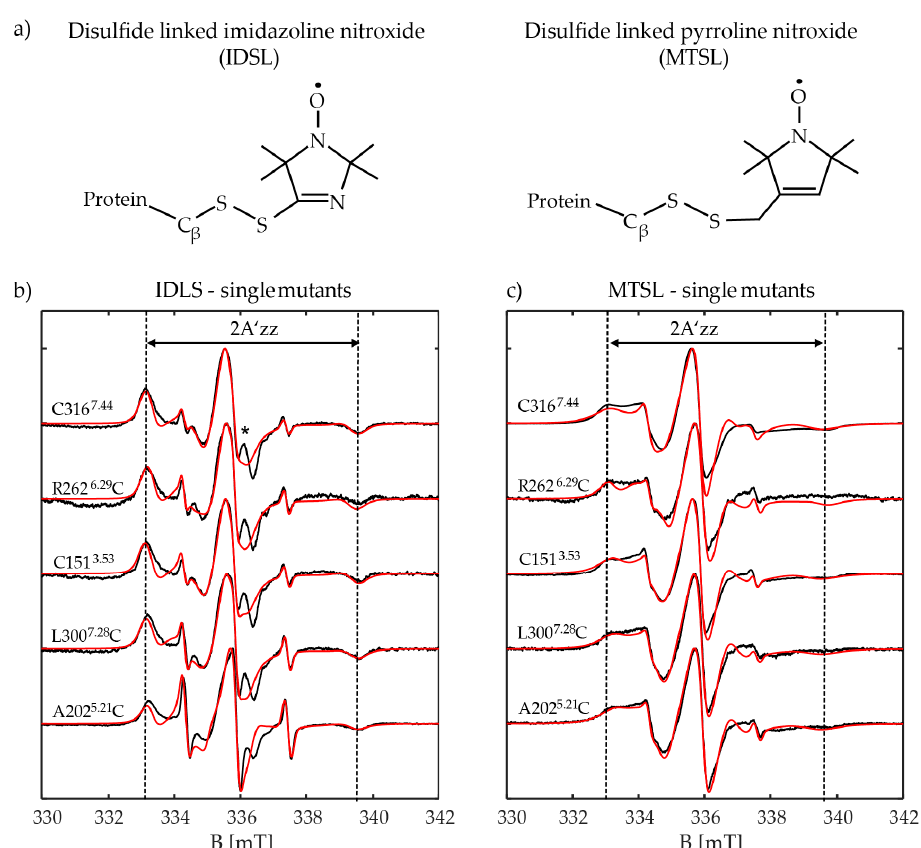
Figure 6. X-band room temperature continuous wave (CW)-EPR measurements of the single cysteine mutants of the Y 2 R: ( a ) chemical structures of IDSL and MTSL are displayed; ( b ) experimental (black) and simulated (red) spectra of Y 2 R single cysteine mutants labeled with IDSL and ( c ) with MTSL. The asterisk indicates the residual fraction of IDSL which is attached to the cysteines of the incompletely formed native disulfide bridge. The distance between the two outermost lines, indicate the apparent hyperfine coupling of the bound spin label to protein (2A’zz).